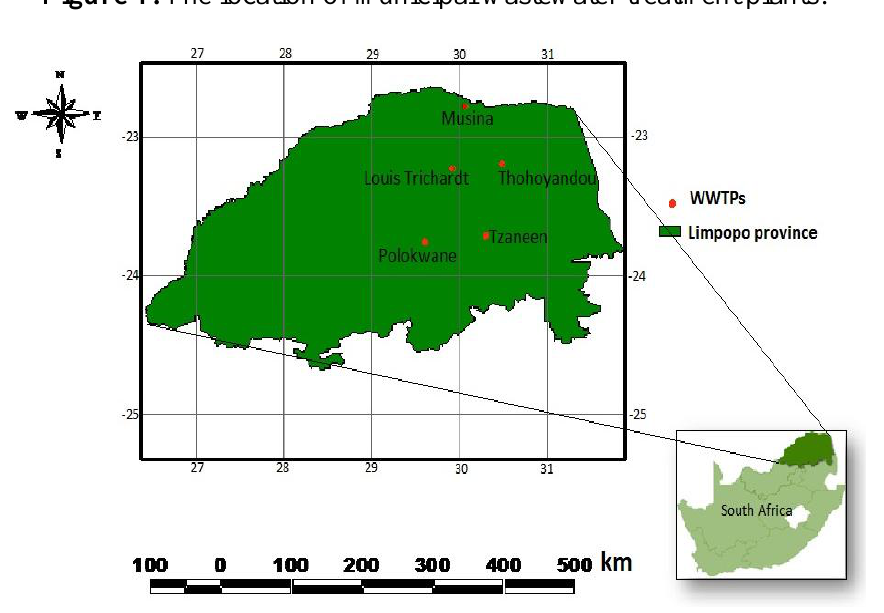
Figure 1. The location of municipal wastewater treatment